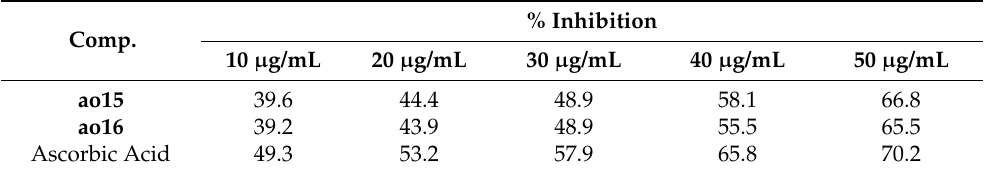
Table 61. In vitro antioxidant activity of the synthesized compounds ( ao15 – ao16 ) using the DPPH scavenging method.